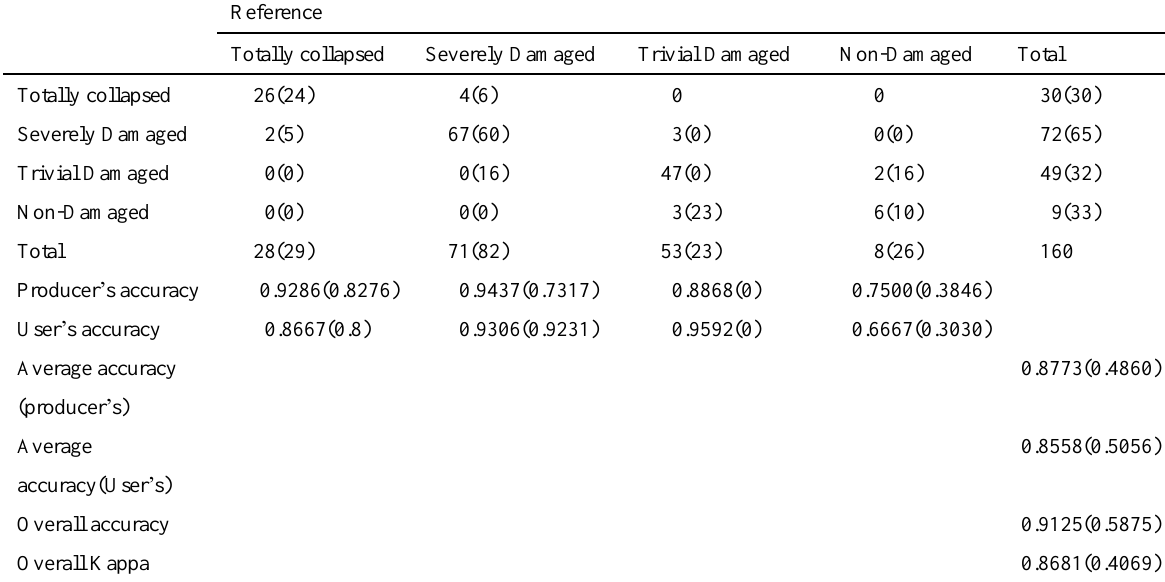
Table 2 Result of the confusion matrix for the detection of building damage using the proposed approach and